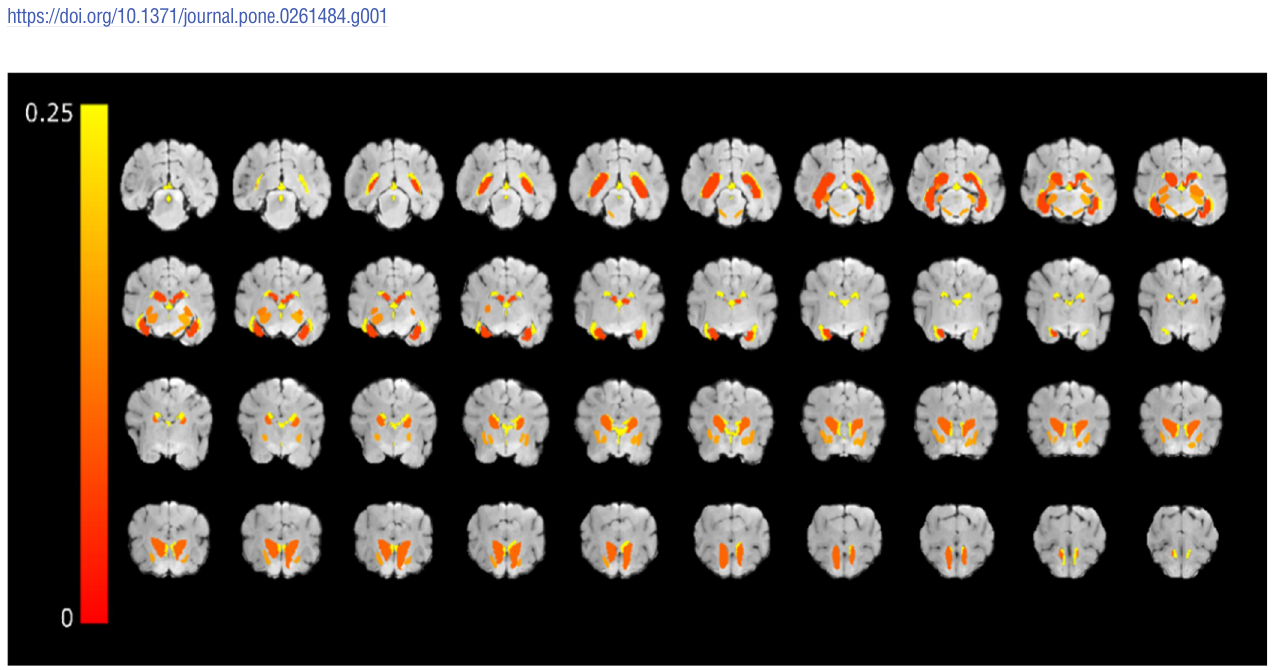
Fig 2. The spatial topography of CV of the considered structures. CV averaged across operators overlaid on T1w images of a representative dog.